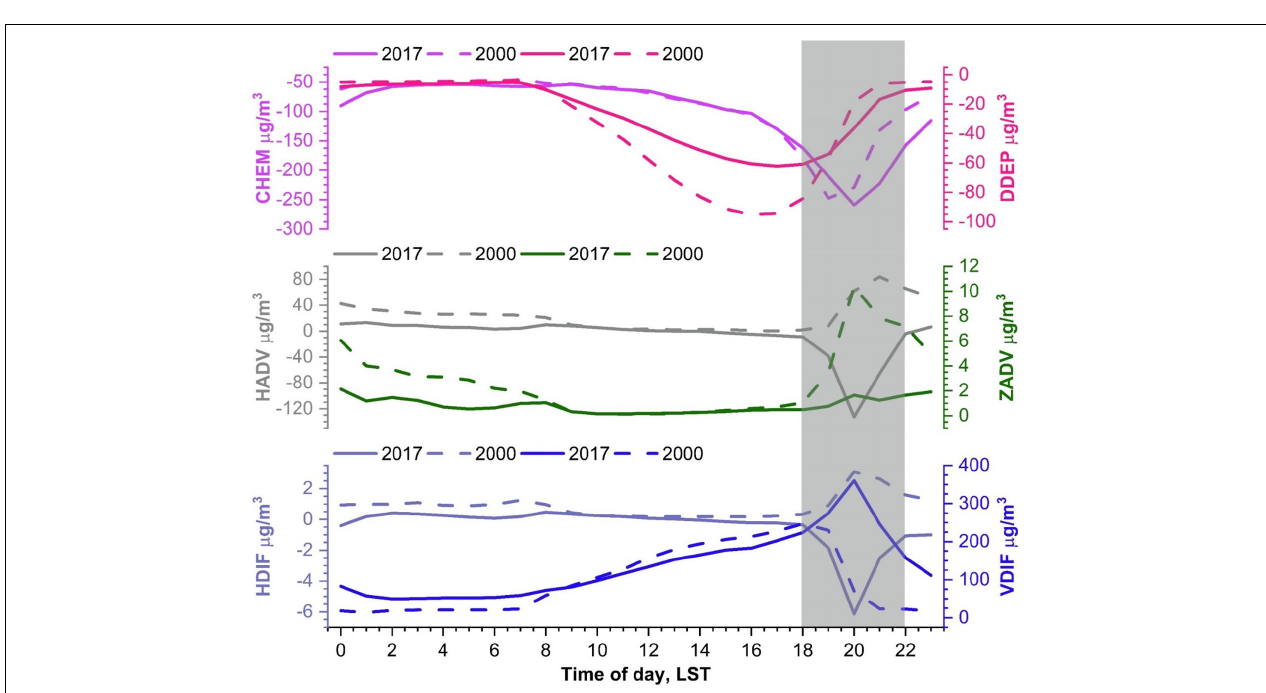
FIGURE 11 | Diurnal pattern of O 3 and NO 2 over UEA of Chengdu between 2000 and 2017. The average data was calculated by the value over UEA.